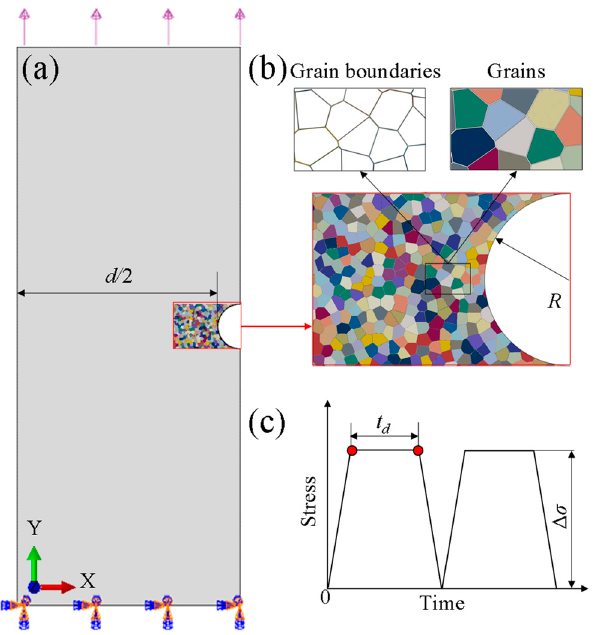
Figure 3. ( a ) Overall finite element model of notch specimen, ( b ) sub-model for crystal plasticity around the notch area and ( c ) creep-fatigue loading waveform.